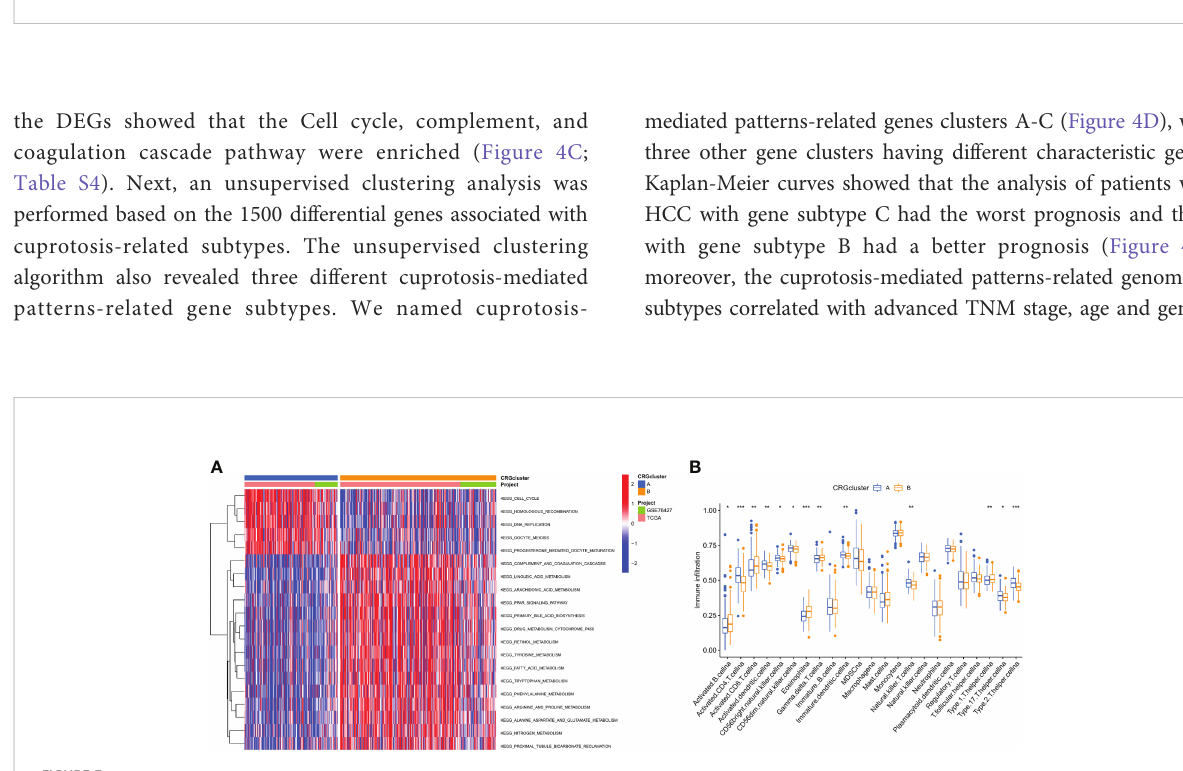
FIGURE 3 Correlations of tumor immune cell microenvironments and two HCC subtypes. (A) GSVA of biological pathways between two distinct subtypes, in which red and blue represent activated and blue inhibited pathways, respectively. (B) Abundance of 22 in fi ltrating immune cell types in the two HCC subtypes. *P < 0.05, **P < 0.01, ***P < 0.001.